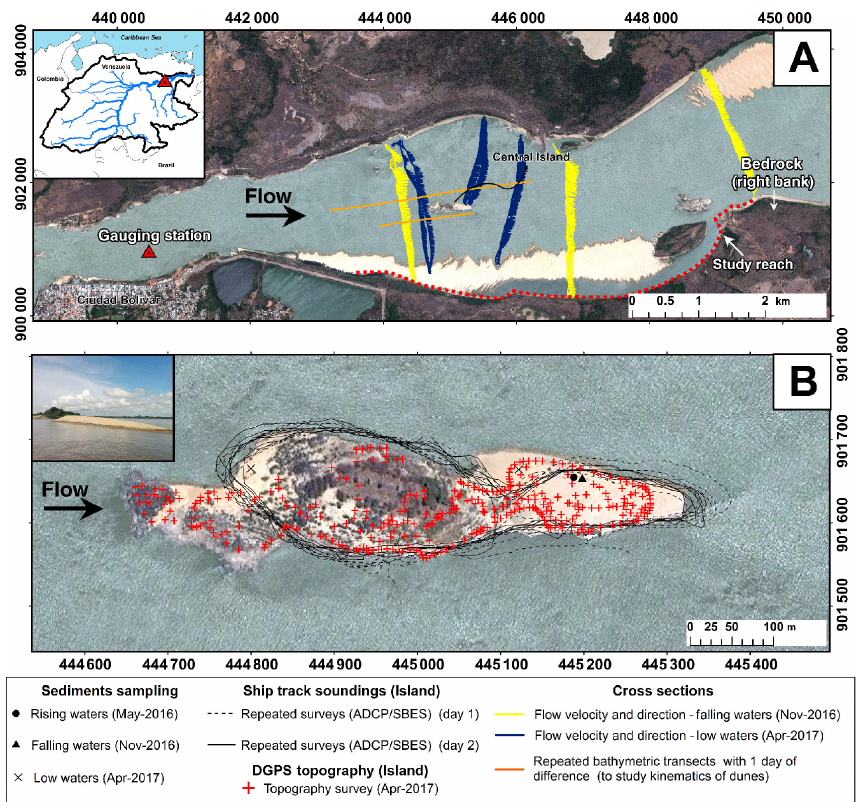
Figure 1. (a) shows ∼ 7km of the study site (Lower Orinoco) drawn with the red dotted line. Channel pattern is developed in a zone of expansion downstream from the gauging station. (b) illustrates the trajectories of the ADCP repeated transects performed during the field